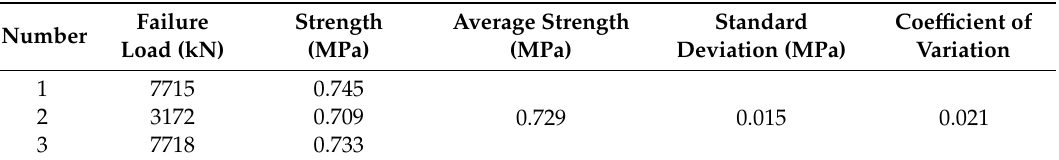
Table 8. The strength test results.